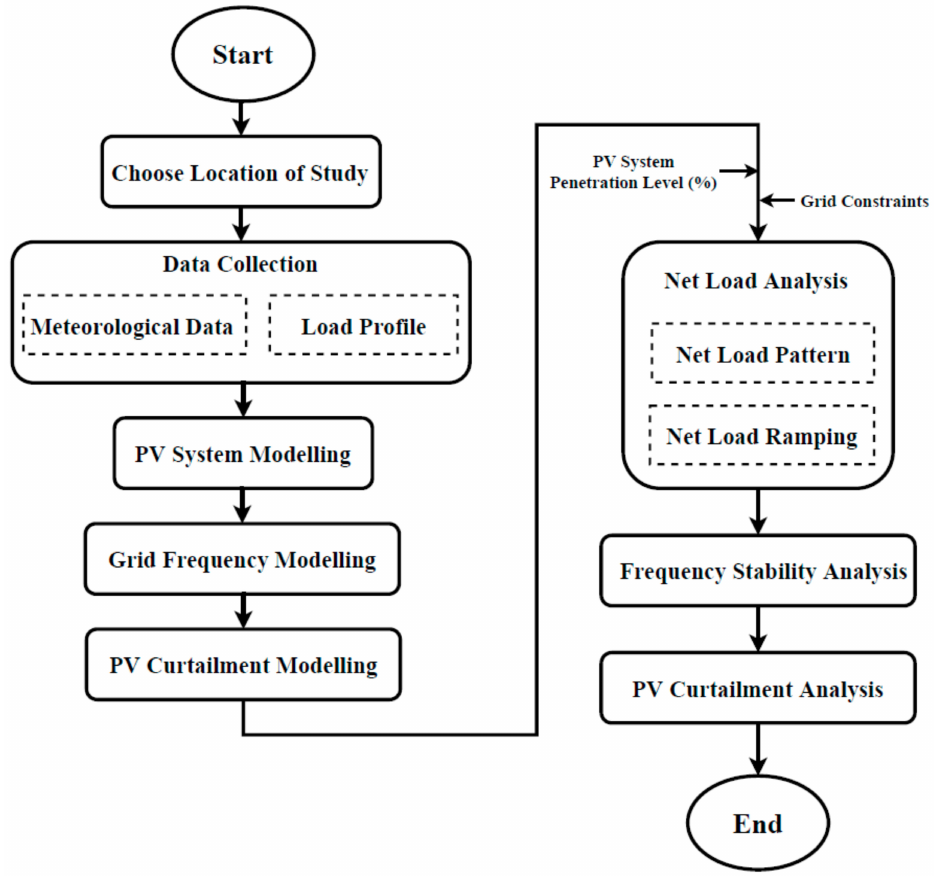
Figure 1. Flowchart of the methodology used to assess the grid’s potential hosting capacity of large-scale integrated PV plants at various penetration